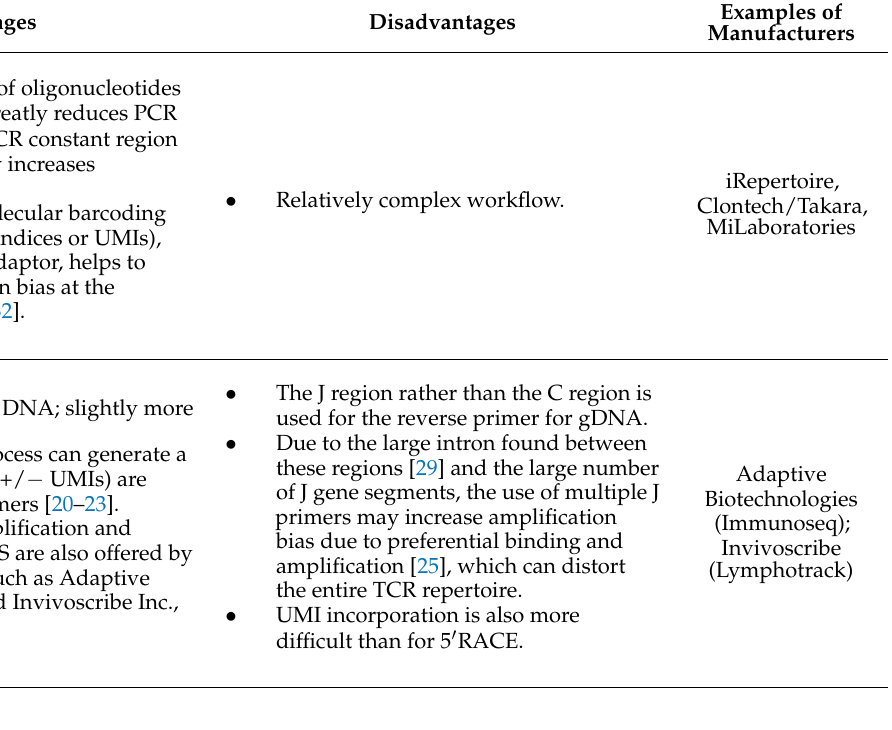
Table 1. Principles of laboratory methods for TCR repertoire